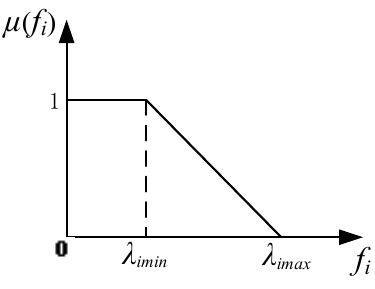
Figure 1. Membership functions of each optimization